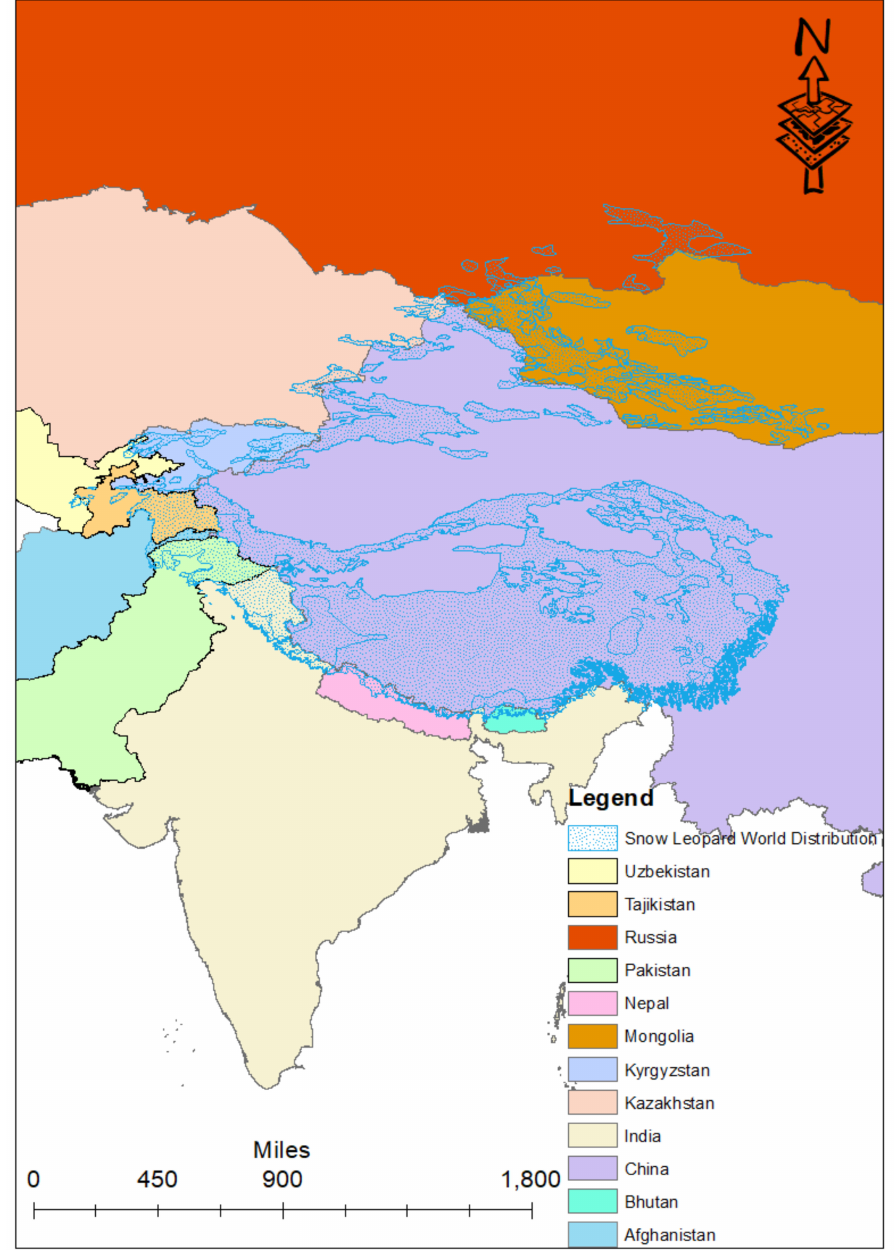
Figure 1. The transboundary snow leopard landscape in the Asian region covering 12